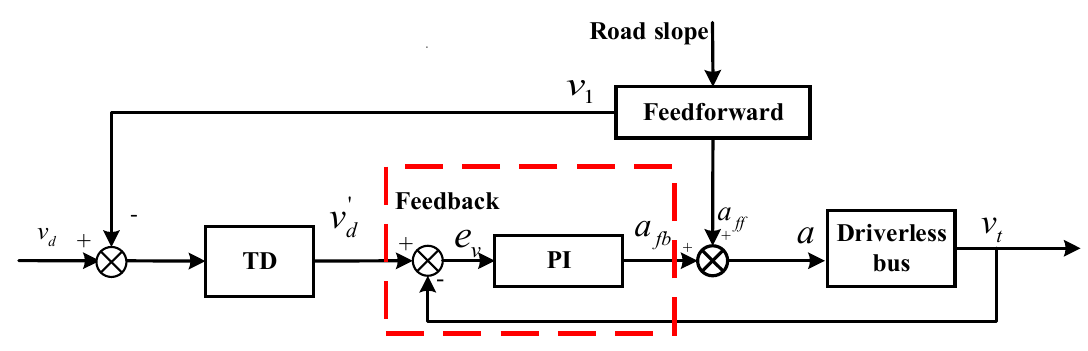
Table 2. Rule base of l’ d . s v PB Table 3. Rule base of k. s v